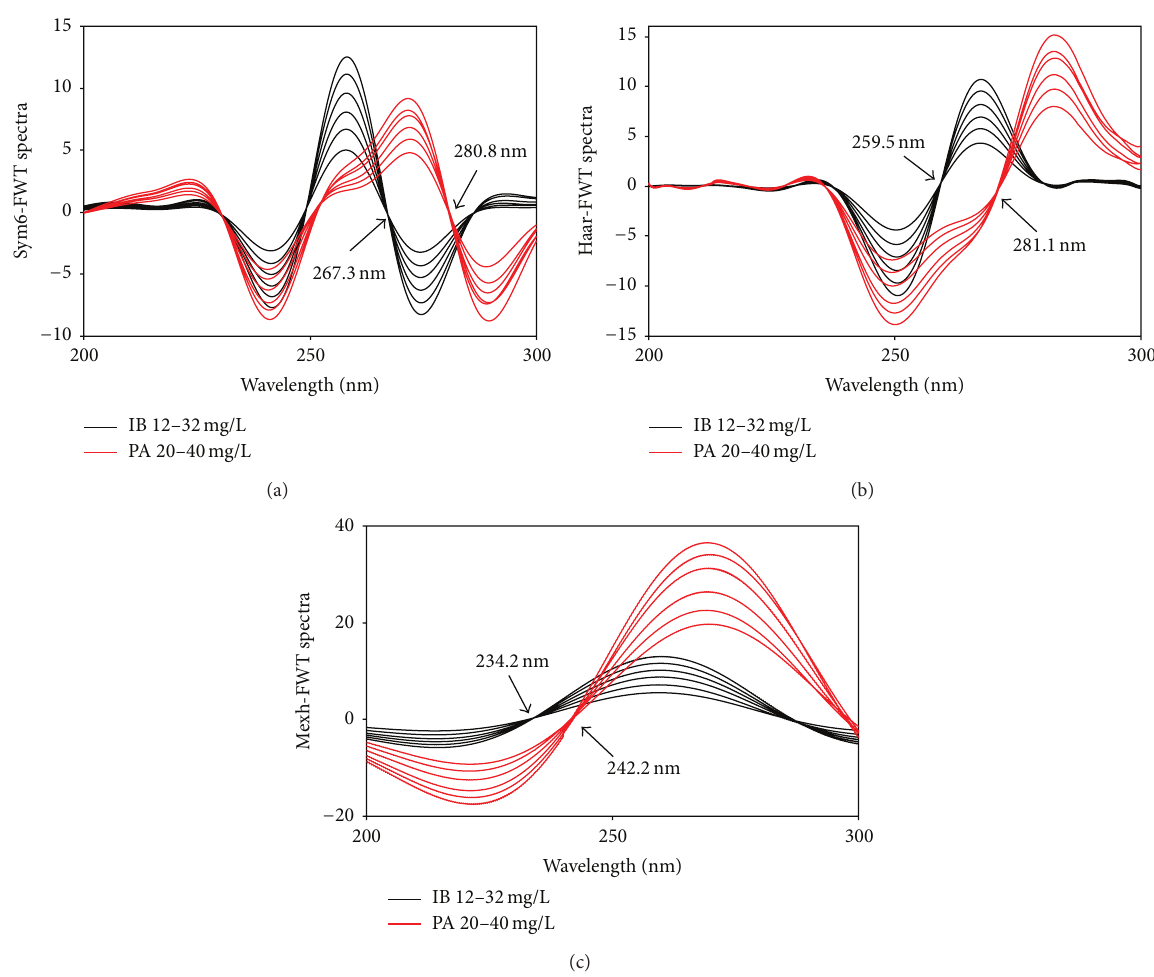
Figure 7: Wavelet transform (sym6 (a), haar (b), and mexh (c)) of FWT-modified